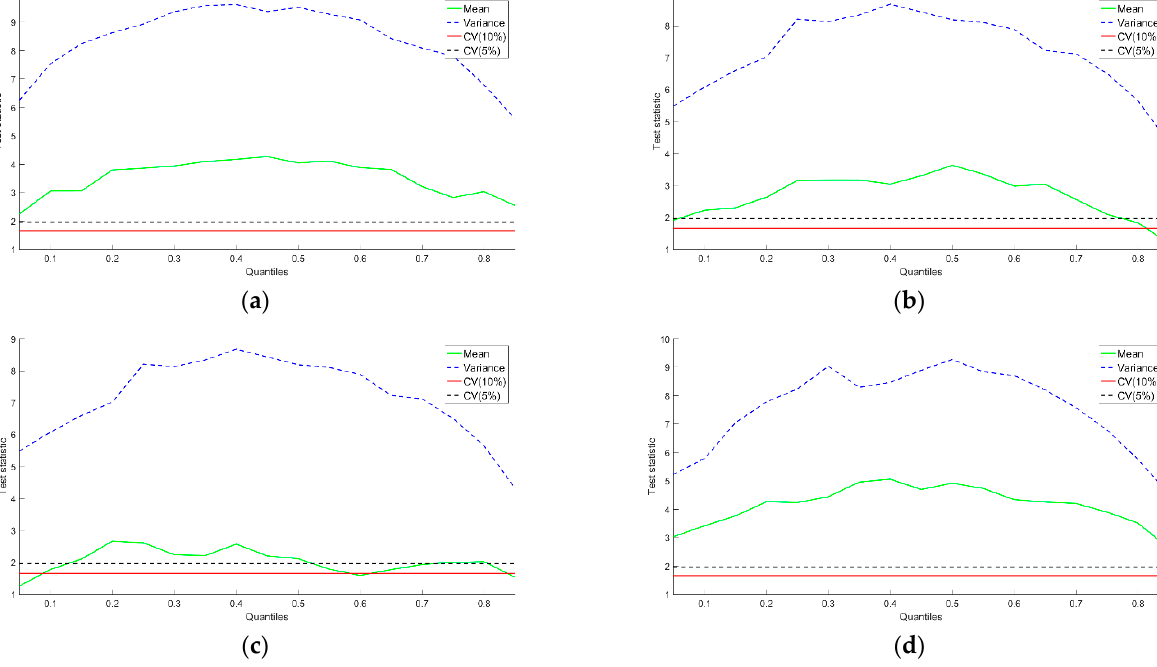
Figure 6. Non-parametric causality-in-mean, in-variance and the 5% and 10% critical values (CV) from oil returns to the stock market returns at various quantiles, respectively: ( a ) OIL-US; ( b ) OIL-CHINA; ( c ) OIL-UK; ( d ) OIL-JAPAN.